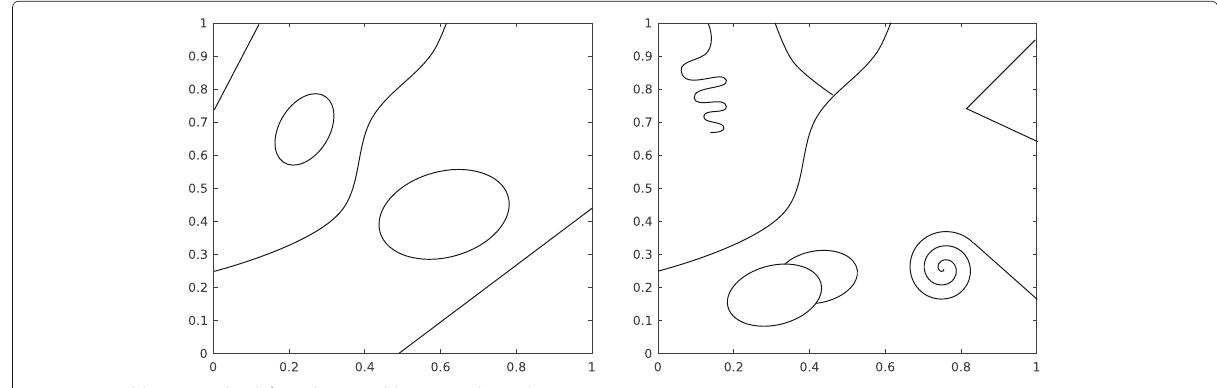
Fig. 10 Possible zero paths ( left ) and impossible zero paths ( right